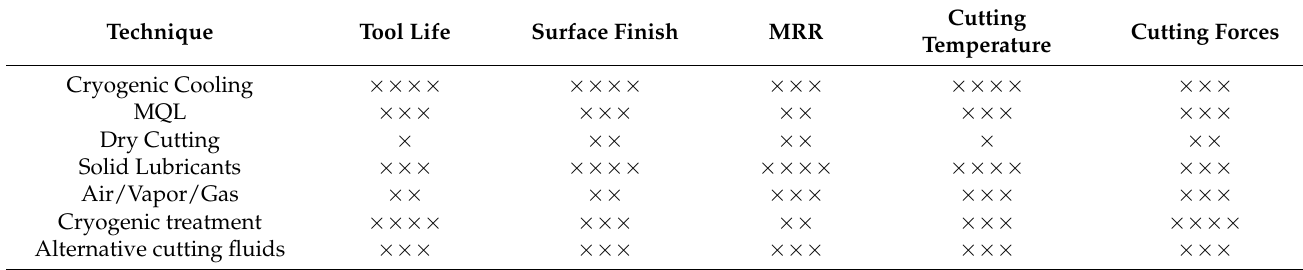
Cutting Cutting Forces Temperature